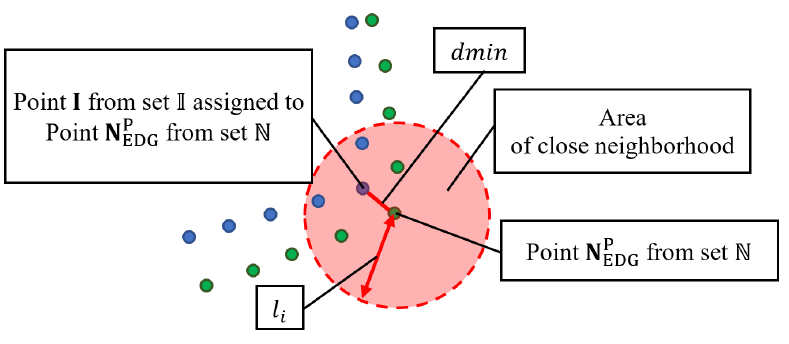
Figure 6. Graphical interpretation of the point association I from the close vicinity of the point N P